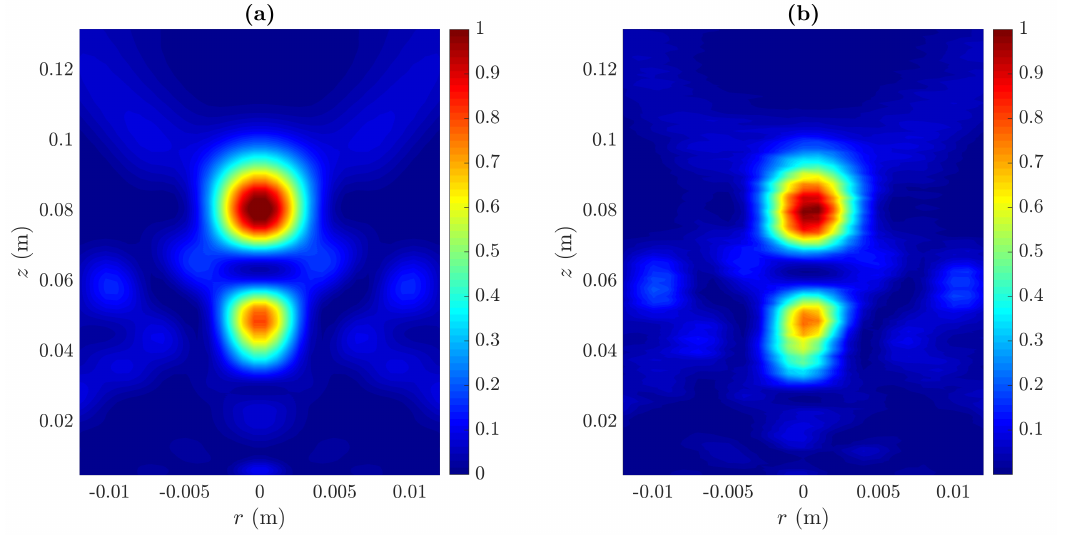
Figure 6. ( a ) Simulated and ( b ) measured normalized acoustic intensity maps for the manufactured BiFZP